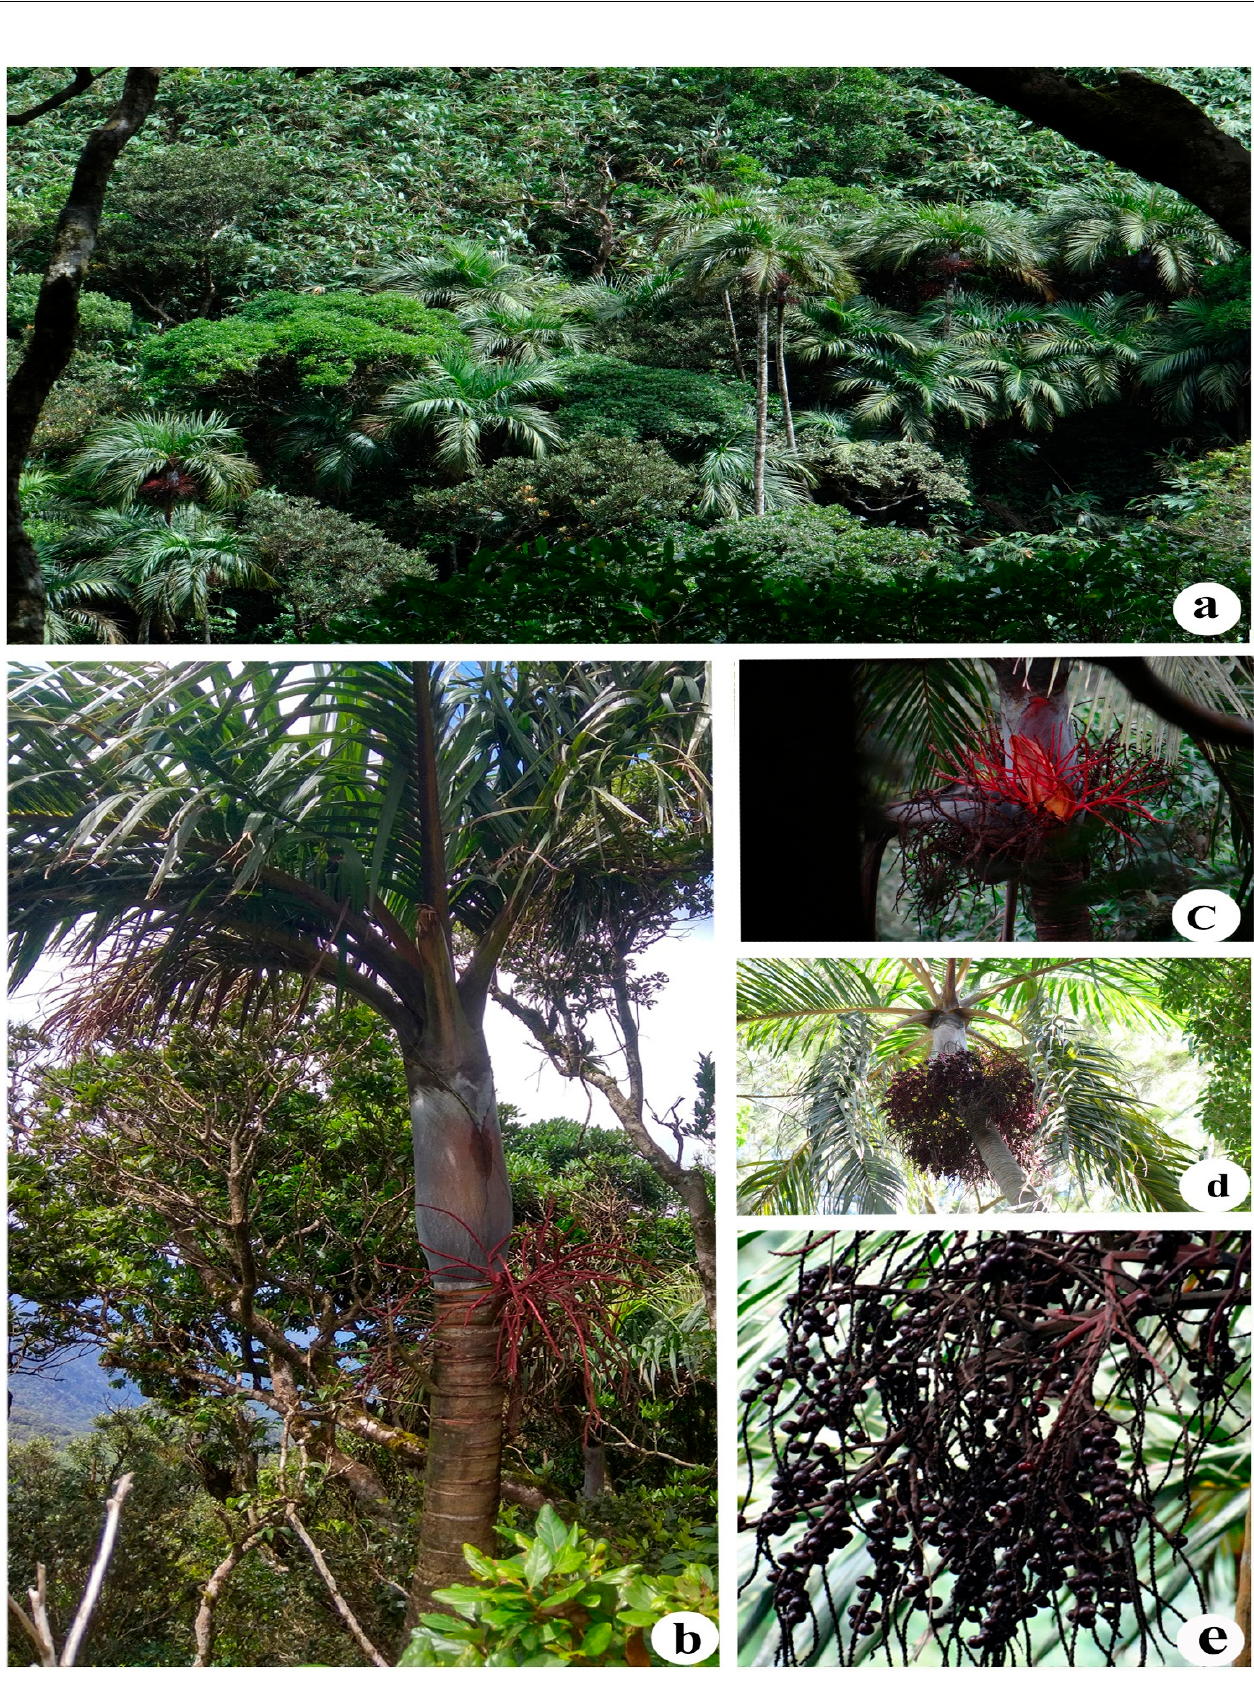
Figure 1. Bentinckia condapanna ( a ) habitat, ( b ) habit, ( c ) inflorescence, ( d ) infructescence, and ( e ) fruits.